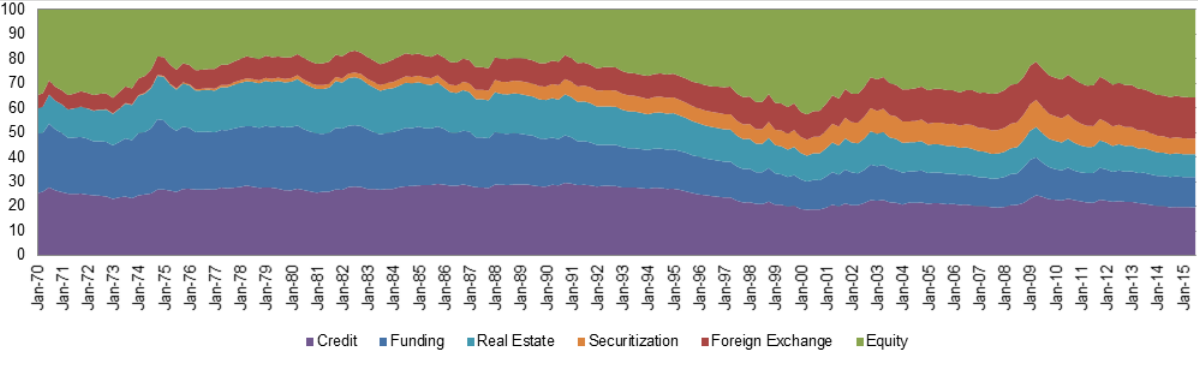
Figure 3. Decomposition of the weight attributed to designated financial system